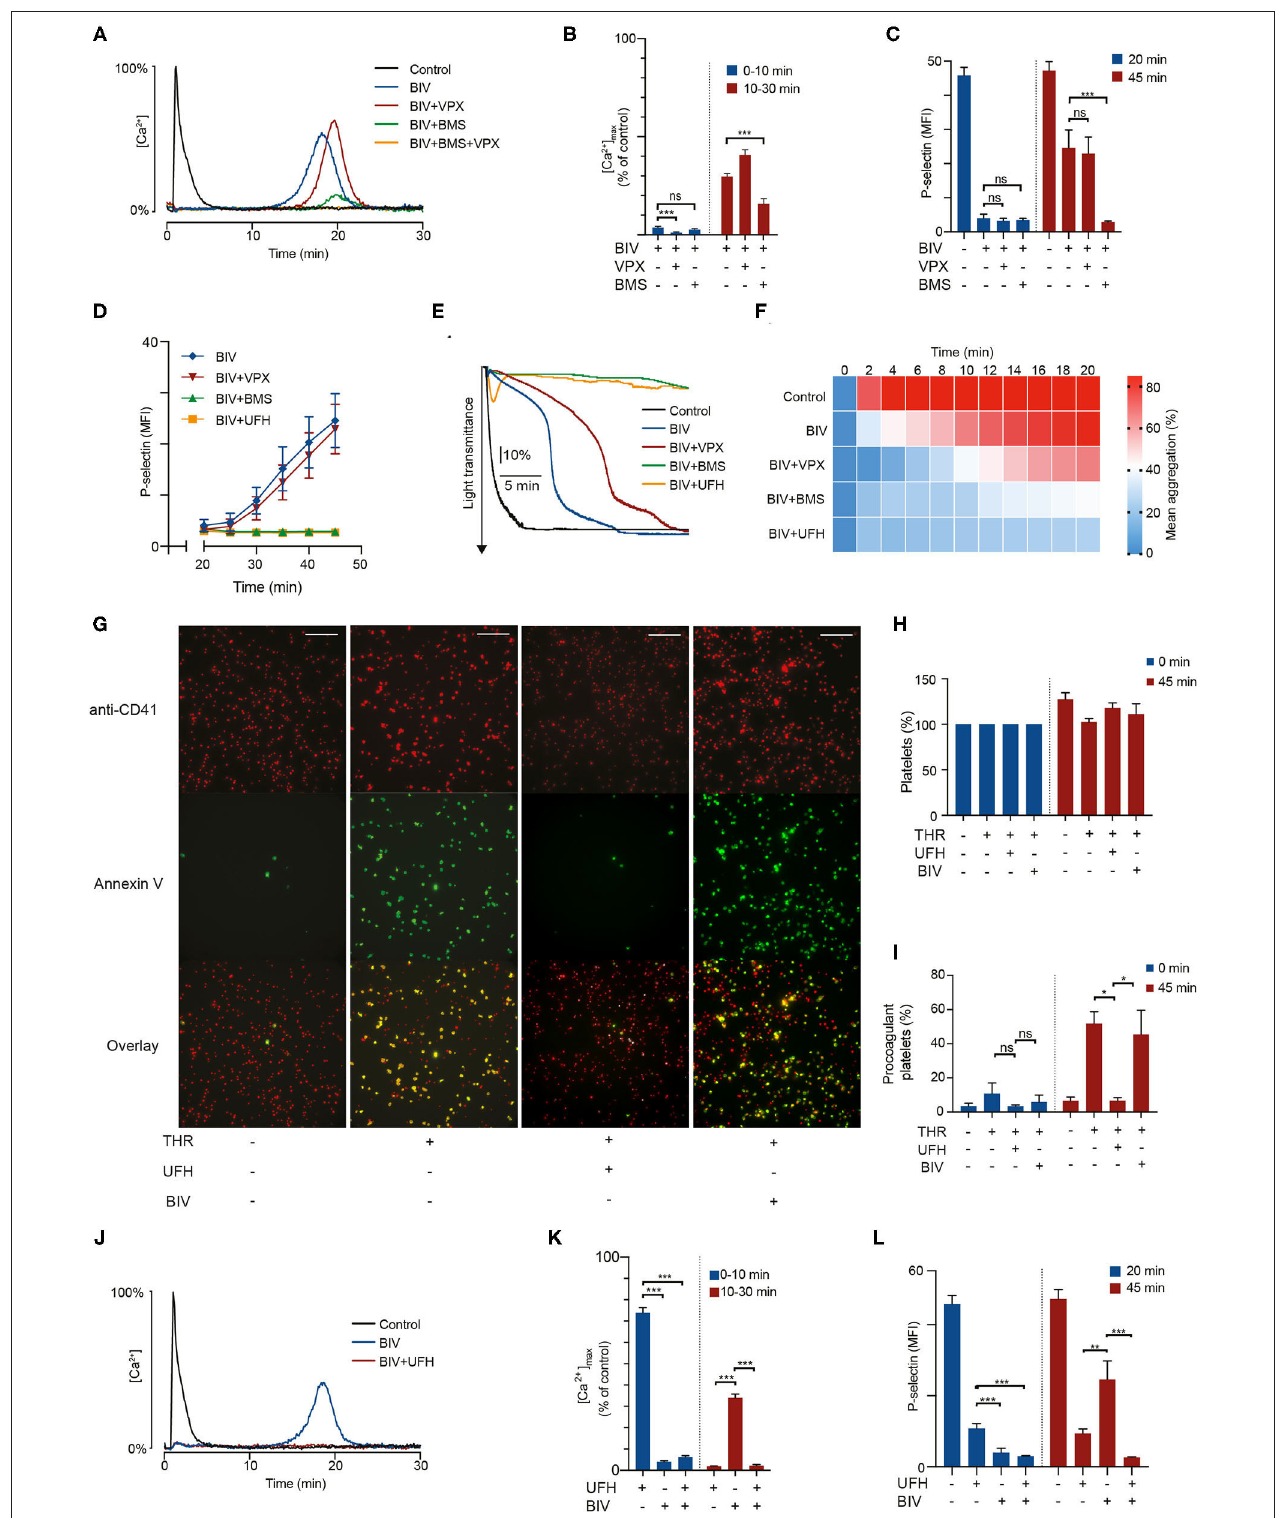
FIGURE 2 | PAR4 activation triggers a delayed prothrombotic response in bivalirudin-treated platelets exposed to thrombin which can be suppressed by sub-therapeutic doses of heparin. Suspensions of washed platelets supplemented with 1 U/mL antithrombin were incubated for 10min with vorapaxar (5 µ mol/L), BMS-986120 (100 nmol/L), heparin (0.2 U/mL), or bivalirudin (1 µ g/mL) as indicated, followed by exposure to 4 U/mL α -thrombin. In (A,B,J,K) , intracellular